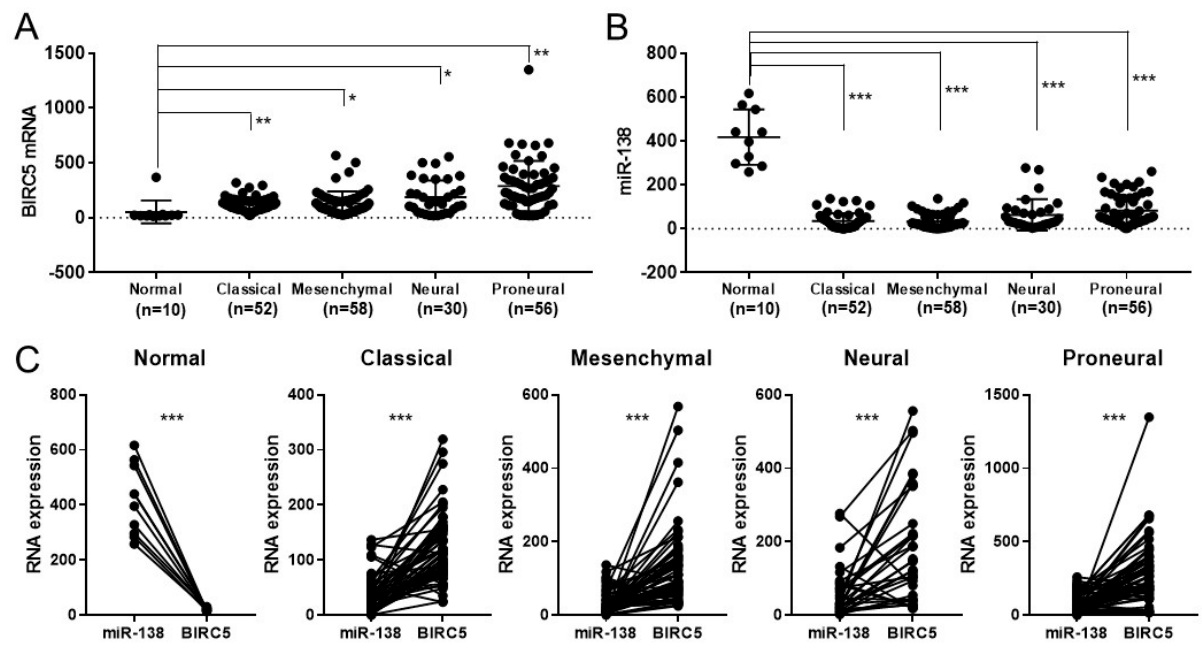
Figure 3. The Cancer Genome Atlas Program (TCGA) database shows inverse correlation between BRIC5 and miR-138 in their expression. ( A ) BIRC5 expression is up-regulated, while ( B ) miR-138 expression is down-regulated in most types of glioma compared to that of normal tissues. ( C ) Direct comparison between BIRC5 and miR-138 clearly reveals inverse correlation in all types of glioma compared to normal tissues. All error bars indicates standard deviations, and Student t -test was used to determine the significance in difference between the two groups. * p < 0.05, ** p < 0.01, *** p < 0.001.